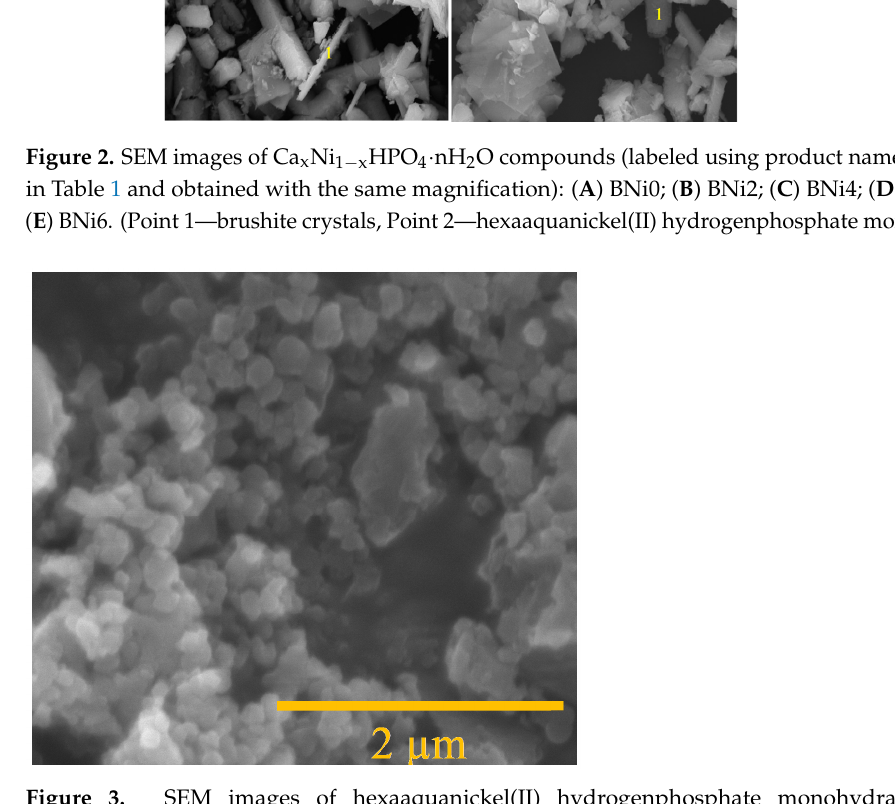
SEM images of hexaaquanickel(II) hydrogenphosphate monohydrate crystals (Ni(H 2 O) 6 ·HPO 4 ·H 2 O (HNiP); product name BNi10).